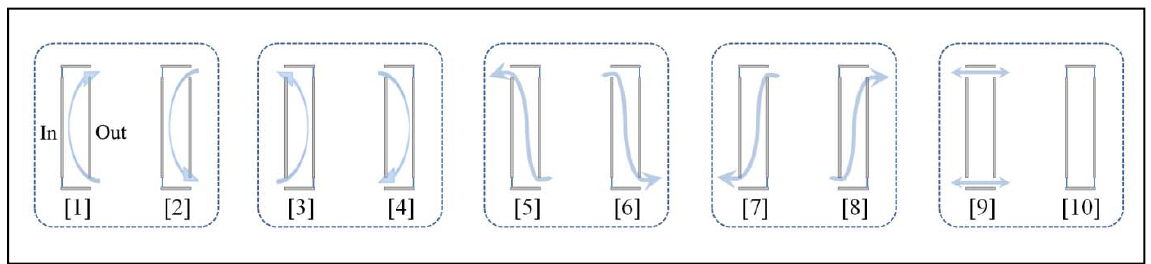
Figure 2. Airflow types of double skin façade.